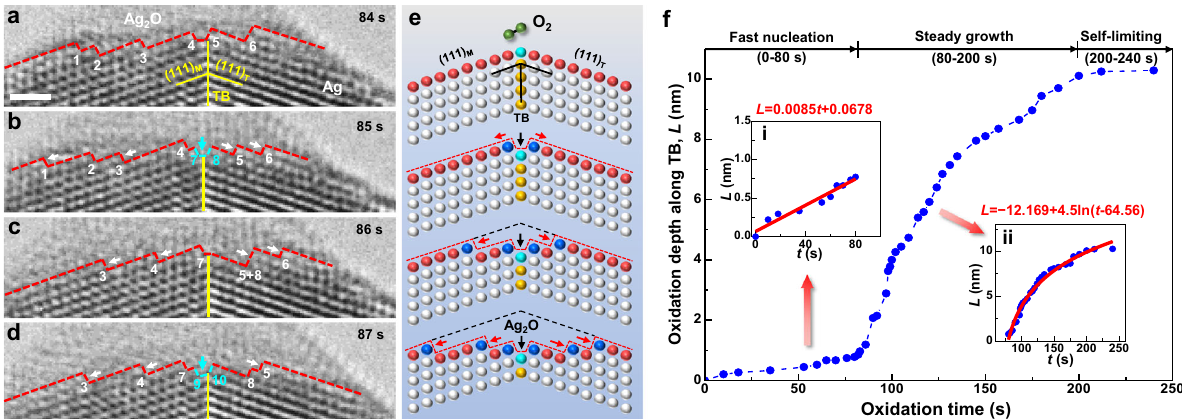
Fig. 4 Dynamics of TB-assisted oxidation in Ag nanocrystal. a The sharp reaction interface between the Ag matrix and the as-formed Ag 2 O containing atomic steps (#1 – 6). b Inward oxidation along the TB, as shown by the dissolution of atoms at the TB tip (pointed out by the aqua arrow) into the oxide (Ag 2 O), which induces two new atomic steps (#7 and 8). c , d Consecutive nucleation of interface steps from the TB junction, which migrate laterally along the conjugate (111) facets, leading to layer-by-layer oxidation of the Ag nanocrystal. e Schematic showing the layer-by-layer kinetics of TB-assisted oxidation in Ag nanocrystal. The atom columns at the TB tip, interface steps, and interface terraces are coloured aqua, dark blue and red, respectively. f The time-dependent inward oxide growth (characterized by oxidation depth, L ) along TB in the Ag nanocrystal presented in Fig. 1. The oxidation depth-time plot was obtained by measuring the distance between the original surface – TB junction and the advancing interface – TB junction. Insets are the mathematical fi tting of time-dependent oxide growth during different stages. Scale bar in a : 1